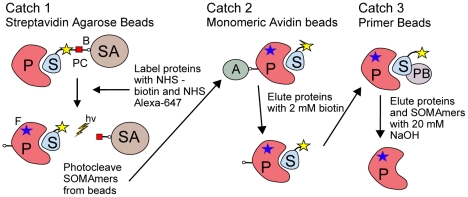
Affinity capture assay.SOMAmers are mixed with the target sample (purified protein or plasma) and incubated to bind to equilibrium. In Catch-1 bound SOMAmer(S)-protein(P) complexes are captured onto streptavidin beads (SA) and the proteins are tagged with biotin (B) (NHS- biotin) and fluorescent label (F) (NHS Alexa 647). Unbound proteins are washed away. Bound complexes are released from the beads by cleaving the photo-cleavable linker (PC) with ultraviolet light. In Catch-2 SOMAmer-protein complexes are captured onto monomeric avidin beads (A), washed, and eluted from the beads with 2 mM biotin. At this stage, SOMAmer-protein complexes are subjected to a kinetic challenge analogous to that used in the proteomics assay. Specific complexes survive the challenge and non-specific complexes dissociate. In the final step, Catch-3, bound complexes are captured onto primer beads (PB) by DNA primer that is complementary to a portion of the SOMAmer and any remaining unbound protein resulting from the kinetic challenge is washed away. Finally, the captured complexes are dissociated with 20 mM NaOH and the target protein is eluted for analysis by PAGE.